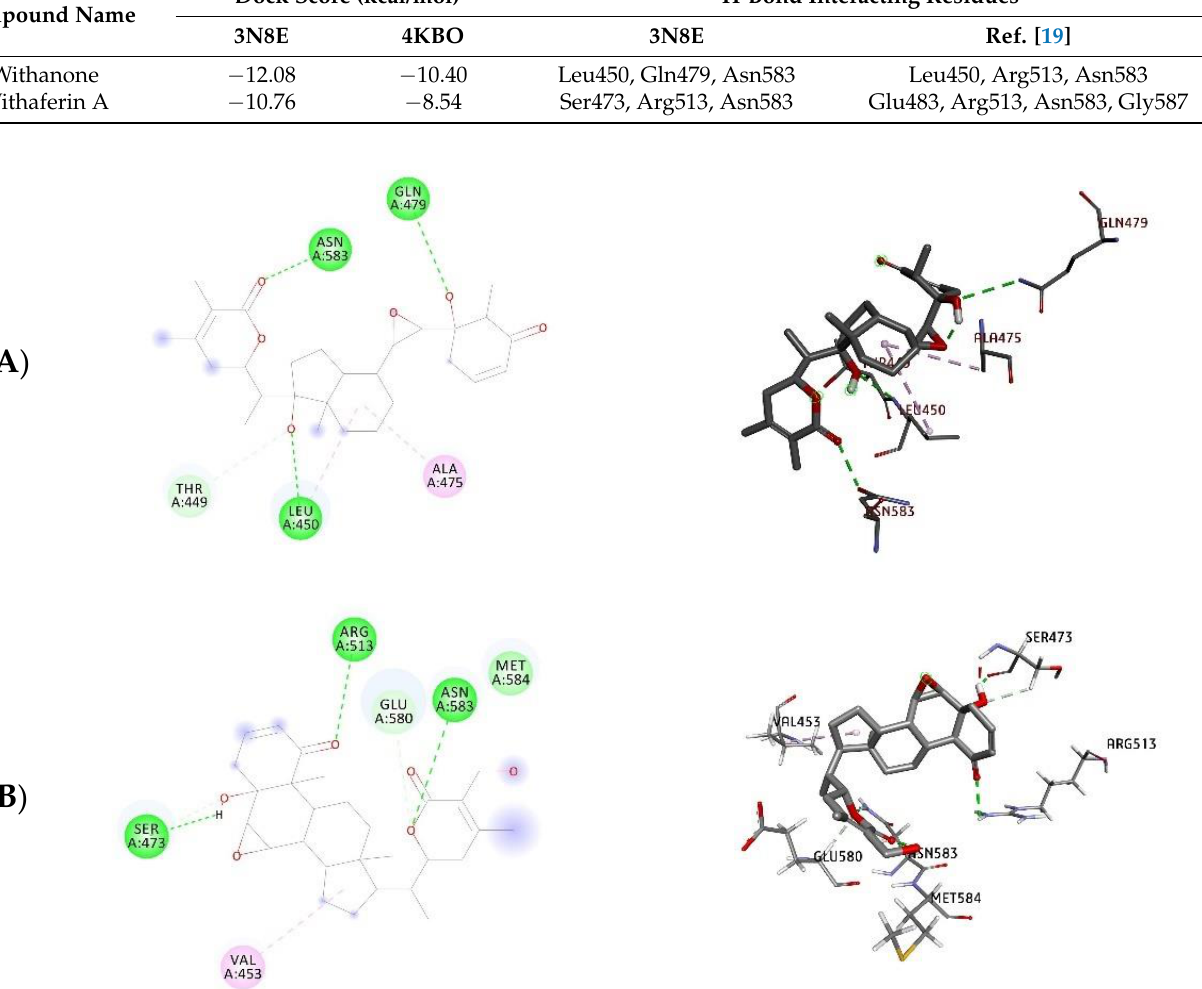
Figure 1. 2D (left panel) and stereoview (right panel) of the binding mode of withanone and withaferin A in the active site of protein Mortalin (PDB ID: 3N8E). ( A ) withanone; ( B ) withaferin A.